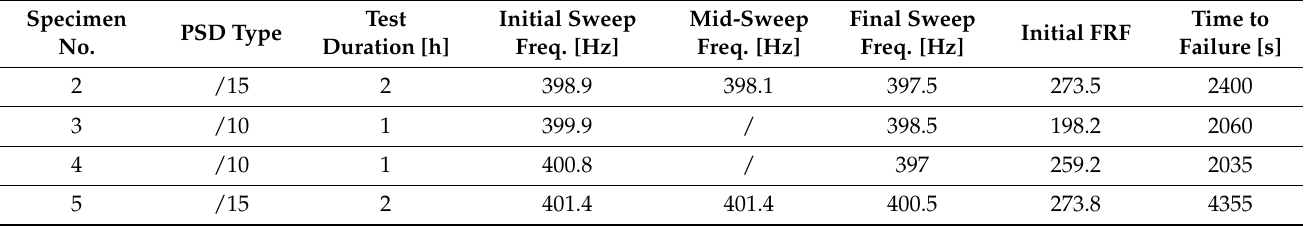
Table 8. Random test results for the FCC lattice